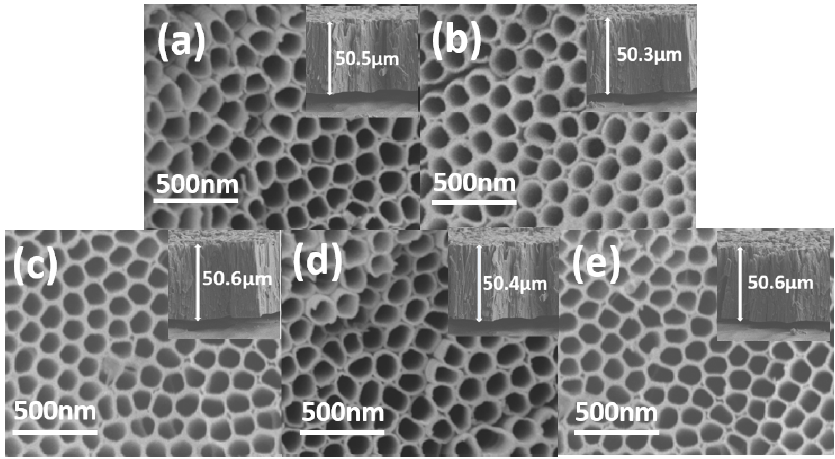
Figure 5. SEM images of TiO 2 nanotube arrays at different voltages. ( a ) 30 V, ( b ) 40 V, ( c ) 50 V, ( d ) 60 V, ( e ) 70 V.